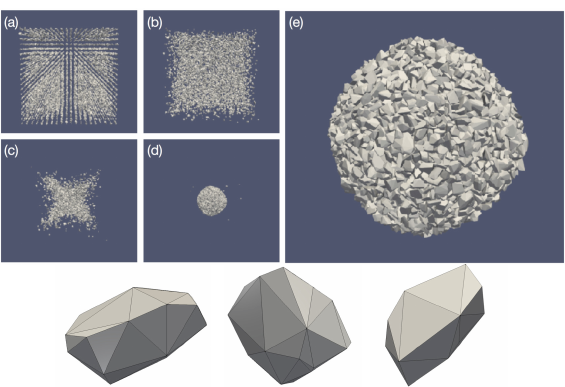
Figure 2. Accretion evolution of 8 000 polyhedra (snapshots a, b, c and d). Shape of the final state aggregate made of polyhedra (e). Examples of polyhedra used in the simulations